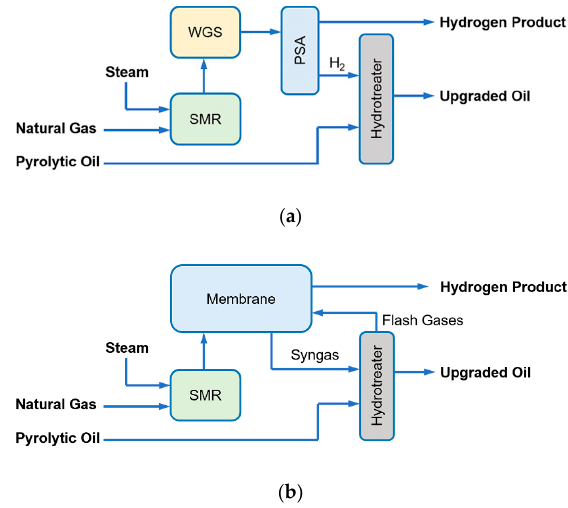
Figure 1. Design and schematics of the integrated hydrogen production and pyrolytic oil upgrading process. ( a ) Conventional process with a water–gas-shift (WGS) reactor and pressure swing adsorption (PSA) unit; ( b ) integrated steam methane reforming-hydrotreating process without a WGS